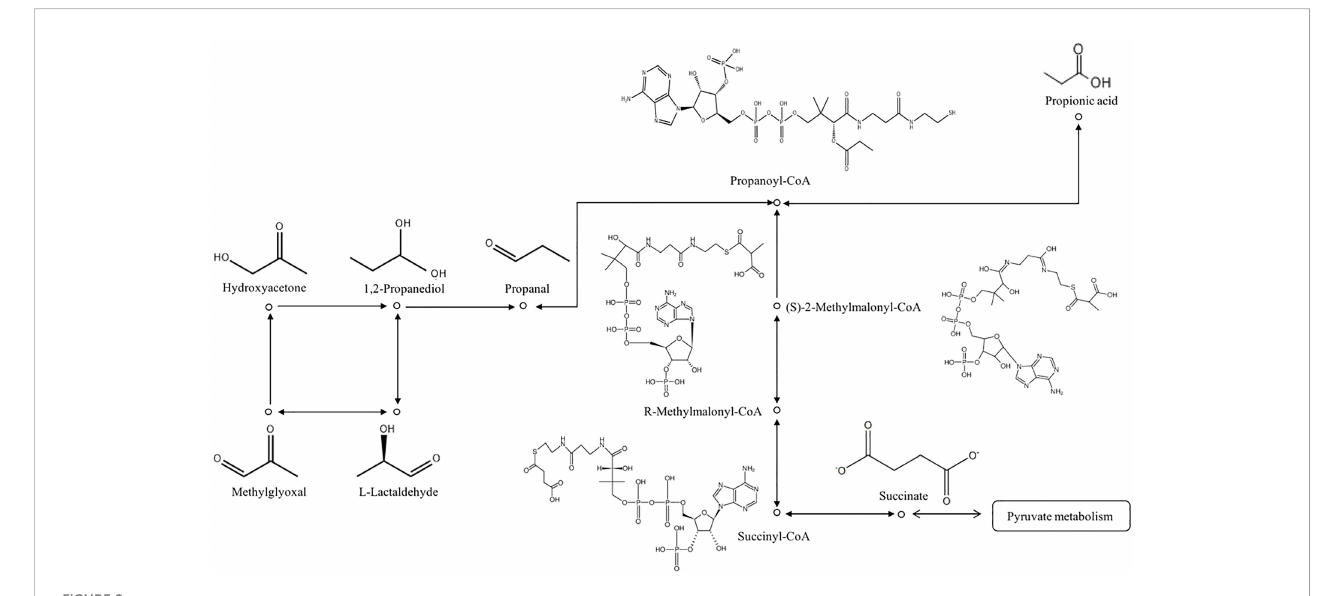
FIGURE 2 Metabolic pathway of propionic